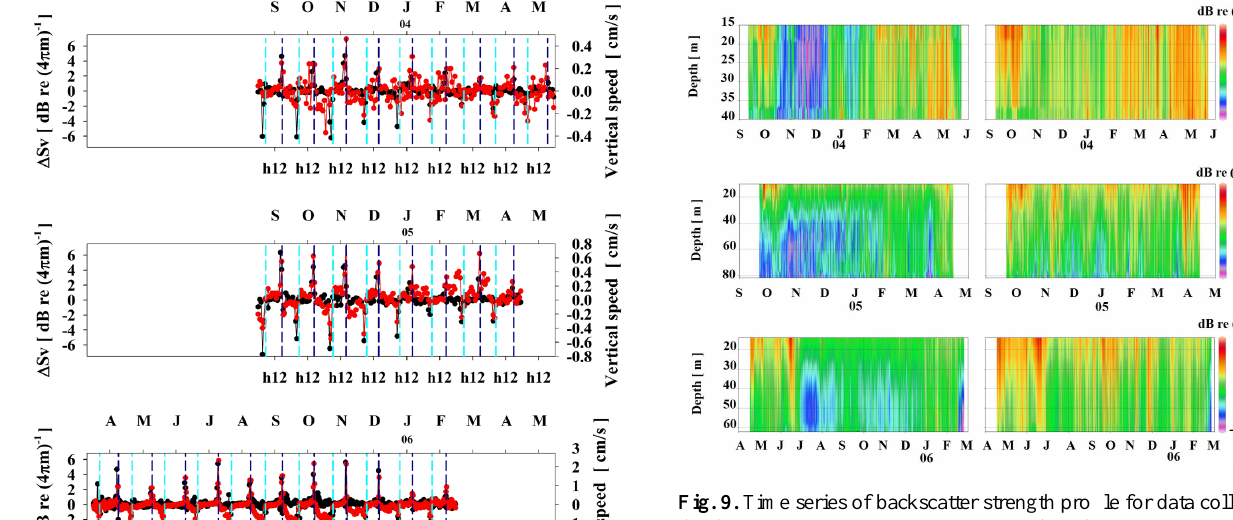
Fig. 9. Time series of backscatter strength profile for data collected (left) between sunrise and sunset and (right) between sunset and sunrise in the three deployments. Year is indicated below January